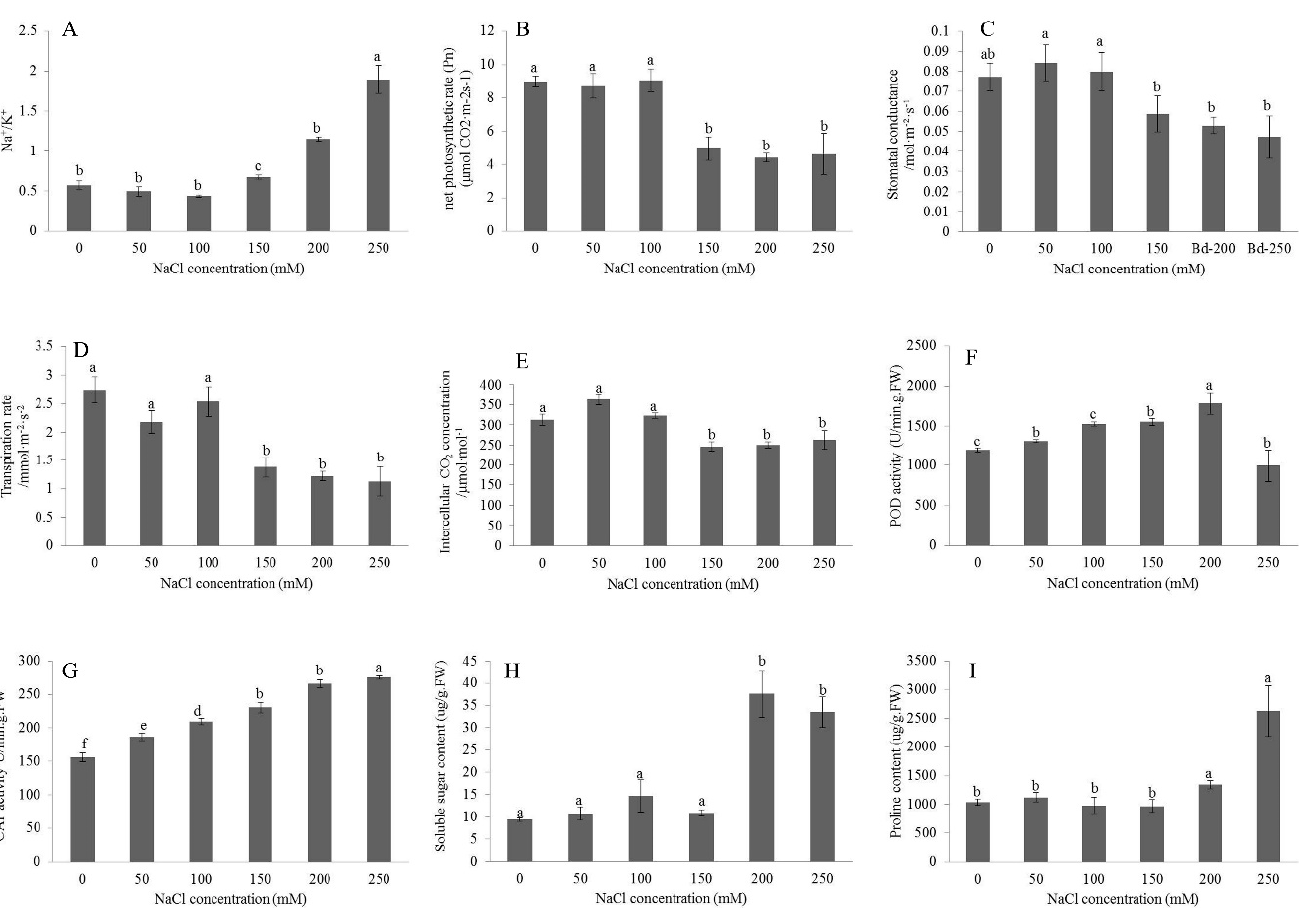
Figure 1. Biochemical parameters of leaf tissue in control group and treated group (200 mM NaCl for 24 h). ( A – I ) represented the change of Na + / K + , net photosynthetic rate (Pn), stomatal conductance (Gs), transpiration rate (Tr), intercellular CO 2 concentration (Ci), peroxidase (POD) activity, catalase (CAT) activity, soluble sugar content and proline content with NaCl concentration respectively. Most of these data were obtained from the average of three biological replicates, among which the data of photosynthesis indicators Pn, Gs, Tr and Ci were got from the means of six biological replicates. The individual black bars are the means ± SD of three or six measurements. The letters on the black bars represent the significance of the di ff